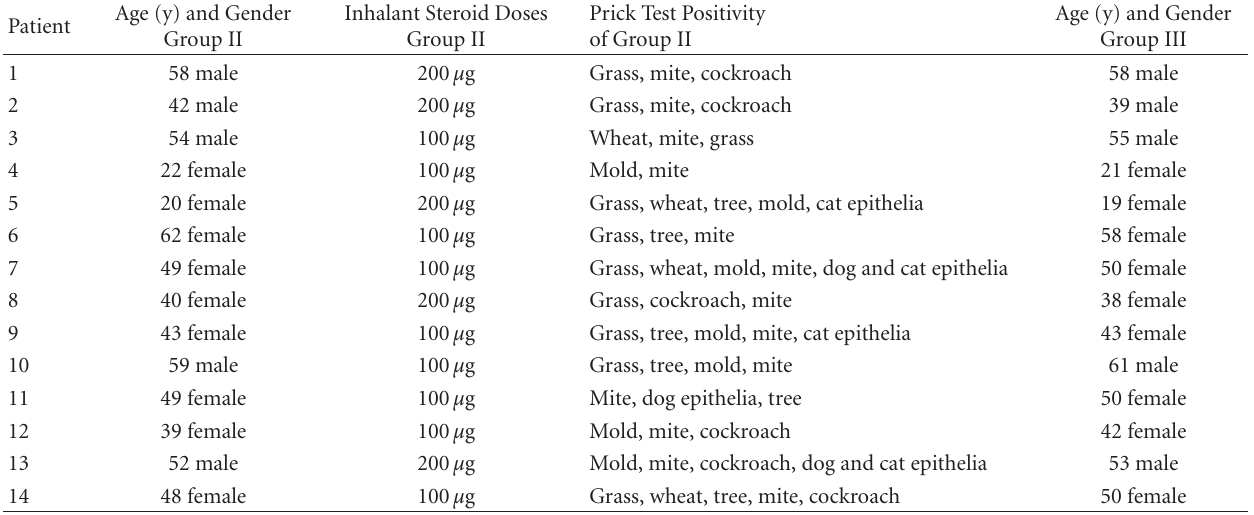
Table 2: Demographics of controlled allergic asthma patients (Group II) and control group (Group